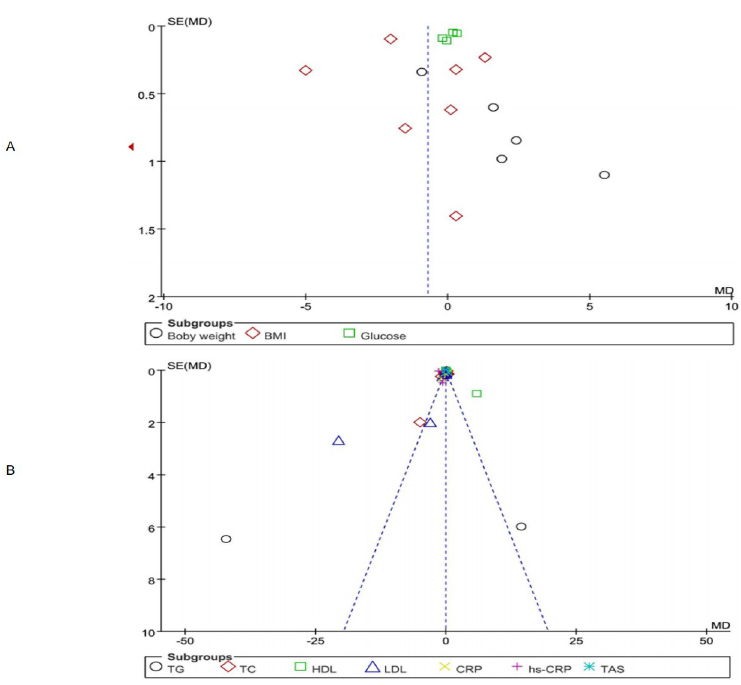
Fig 8. Risk of bias assessment (A) Funnel plot of body weight, BMI, and blood glucose (B) Funnel plot of inflammatory factors.